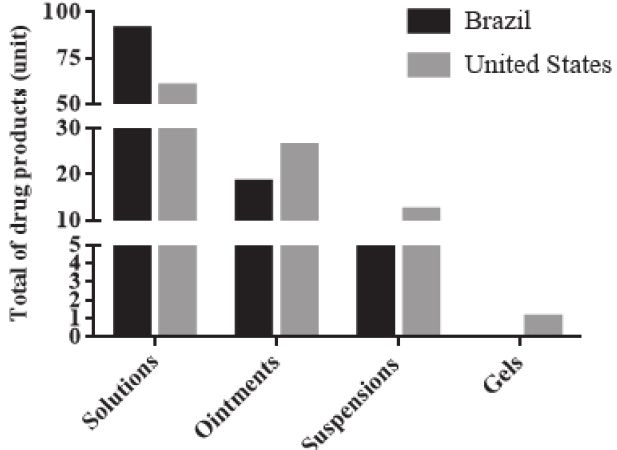
FIGURE 2 - Dosage forms registered for ophthalmic products in Brazil and in the United States.